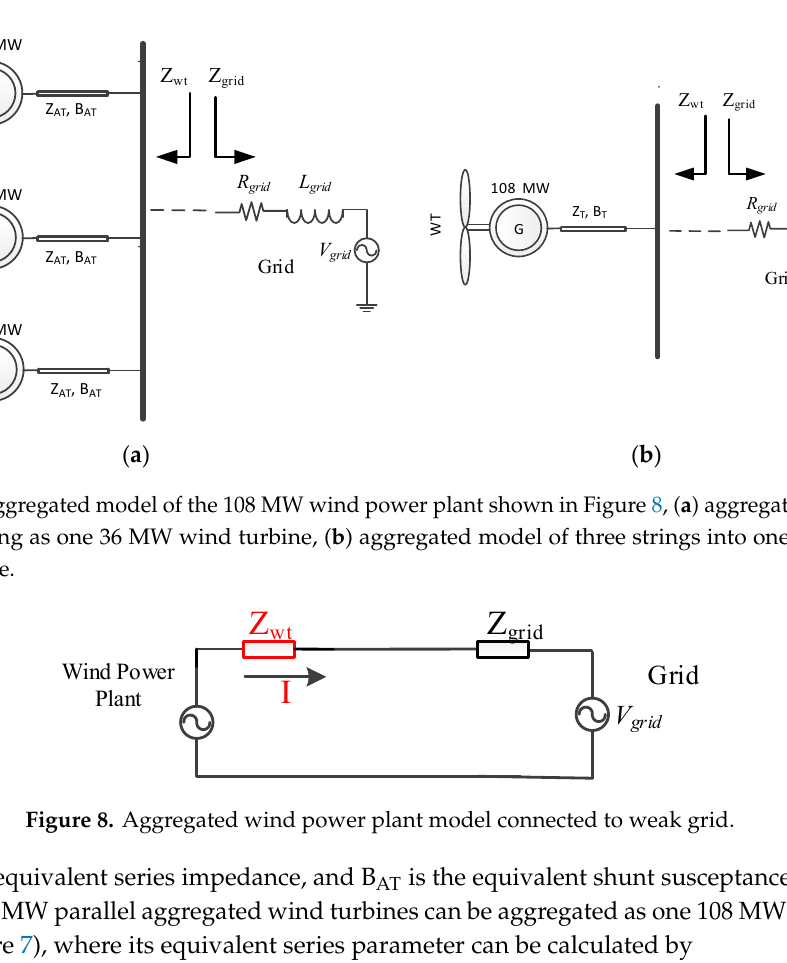
L grid V grid Grid R grid Figure 6. A 108 MW wind power plant, including three 36 MW strings. If it is assumed that the voltages and currents of the wind turbines are the same, ten 3.6 MW wind turbines of each feeder can be aggregated into one 36 MW wind turbine (see Figure 7), where its equivalent series cable parameter can be obtained [31,32] by